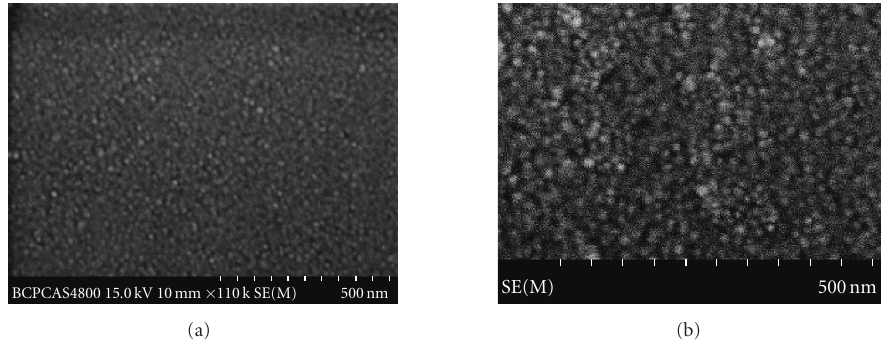
Figure 2: SEM image of TiO 2 film on ITO substrate.